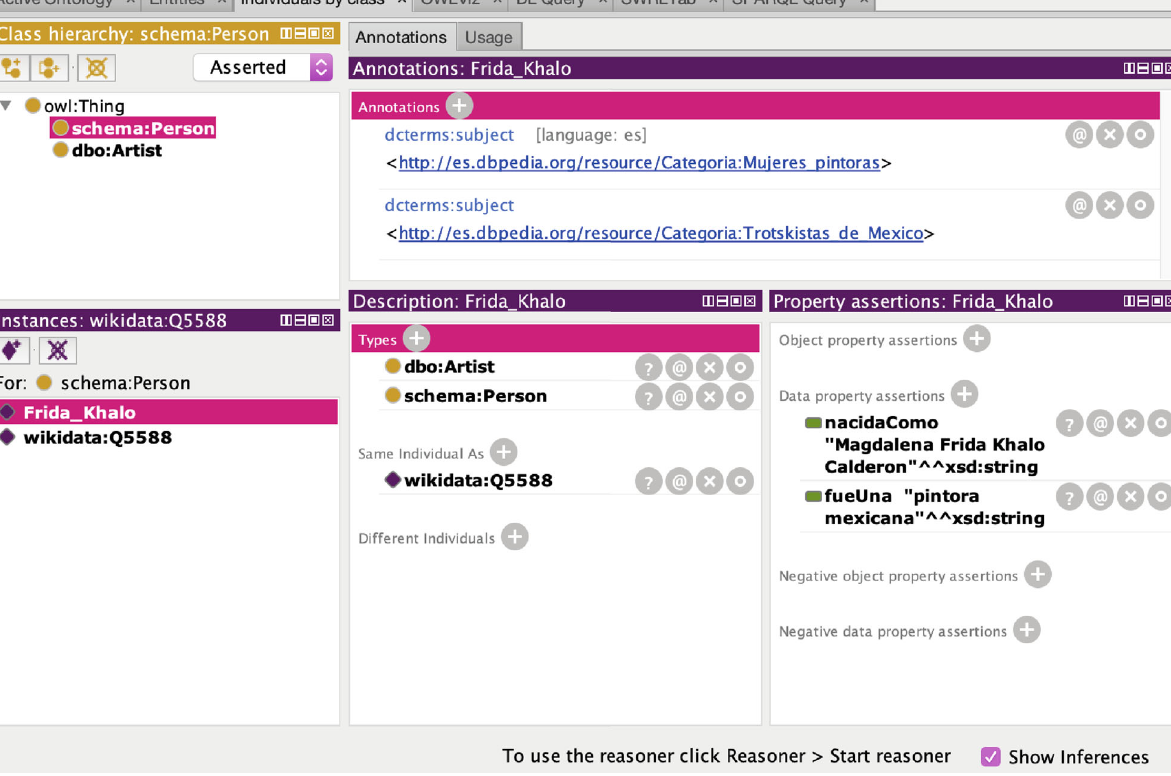
does not consider what is not covered by the